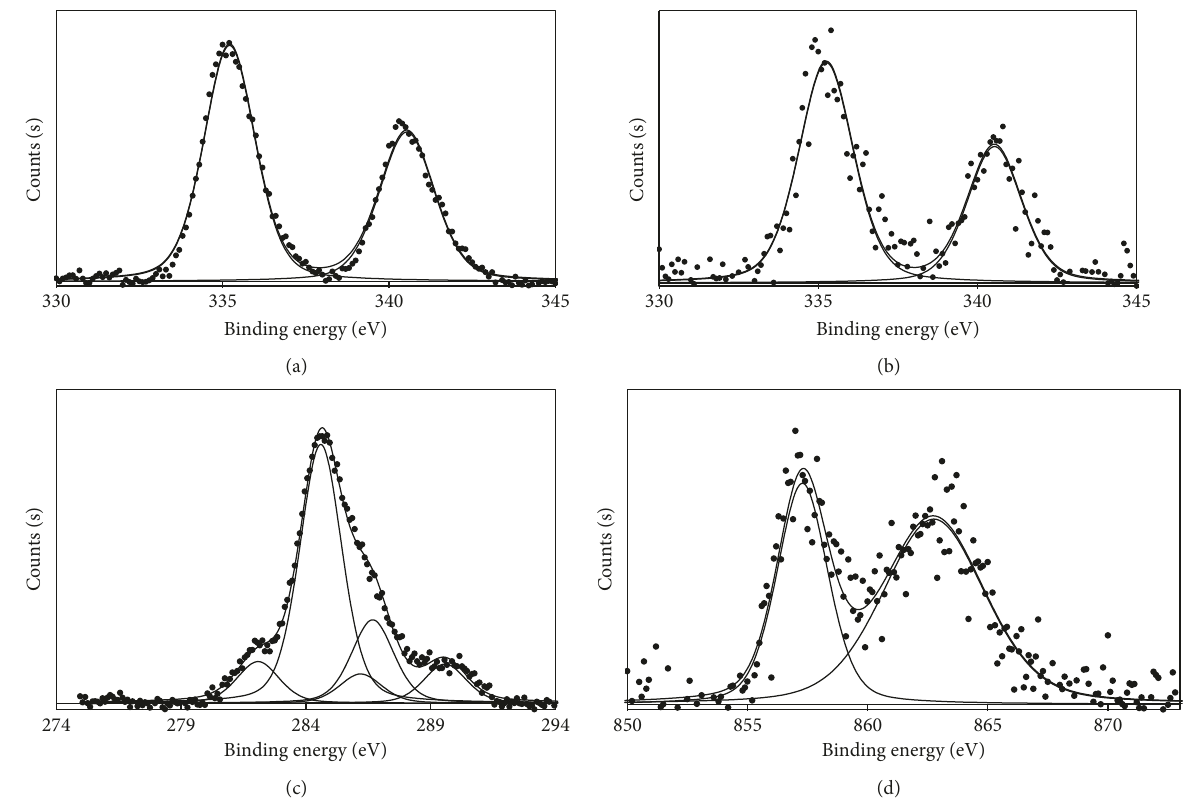
Figure 6: XPS spectra of BE Pd 3d for (a) PdN/C, (b) PdCl/C, (c) RuCl/C, and (d) NiCl/C catalysts treated in H